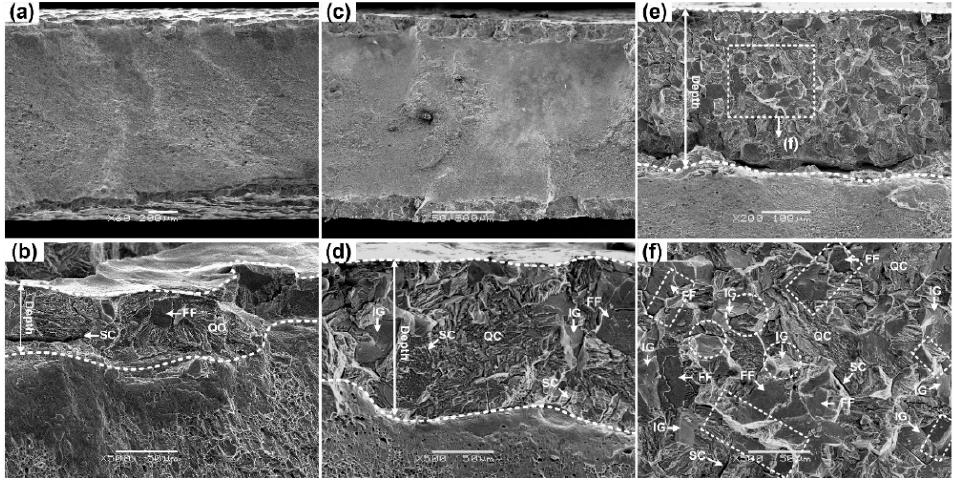
Figure 7. SEM fracture surfaces of the 304L steel specimens: ( a , b ) Un ‐ prestrained; ( c , d ) prestrained to 20% at 20 °C; ( e , f ) prestrained to 40% at 20 °C.